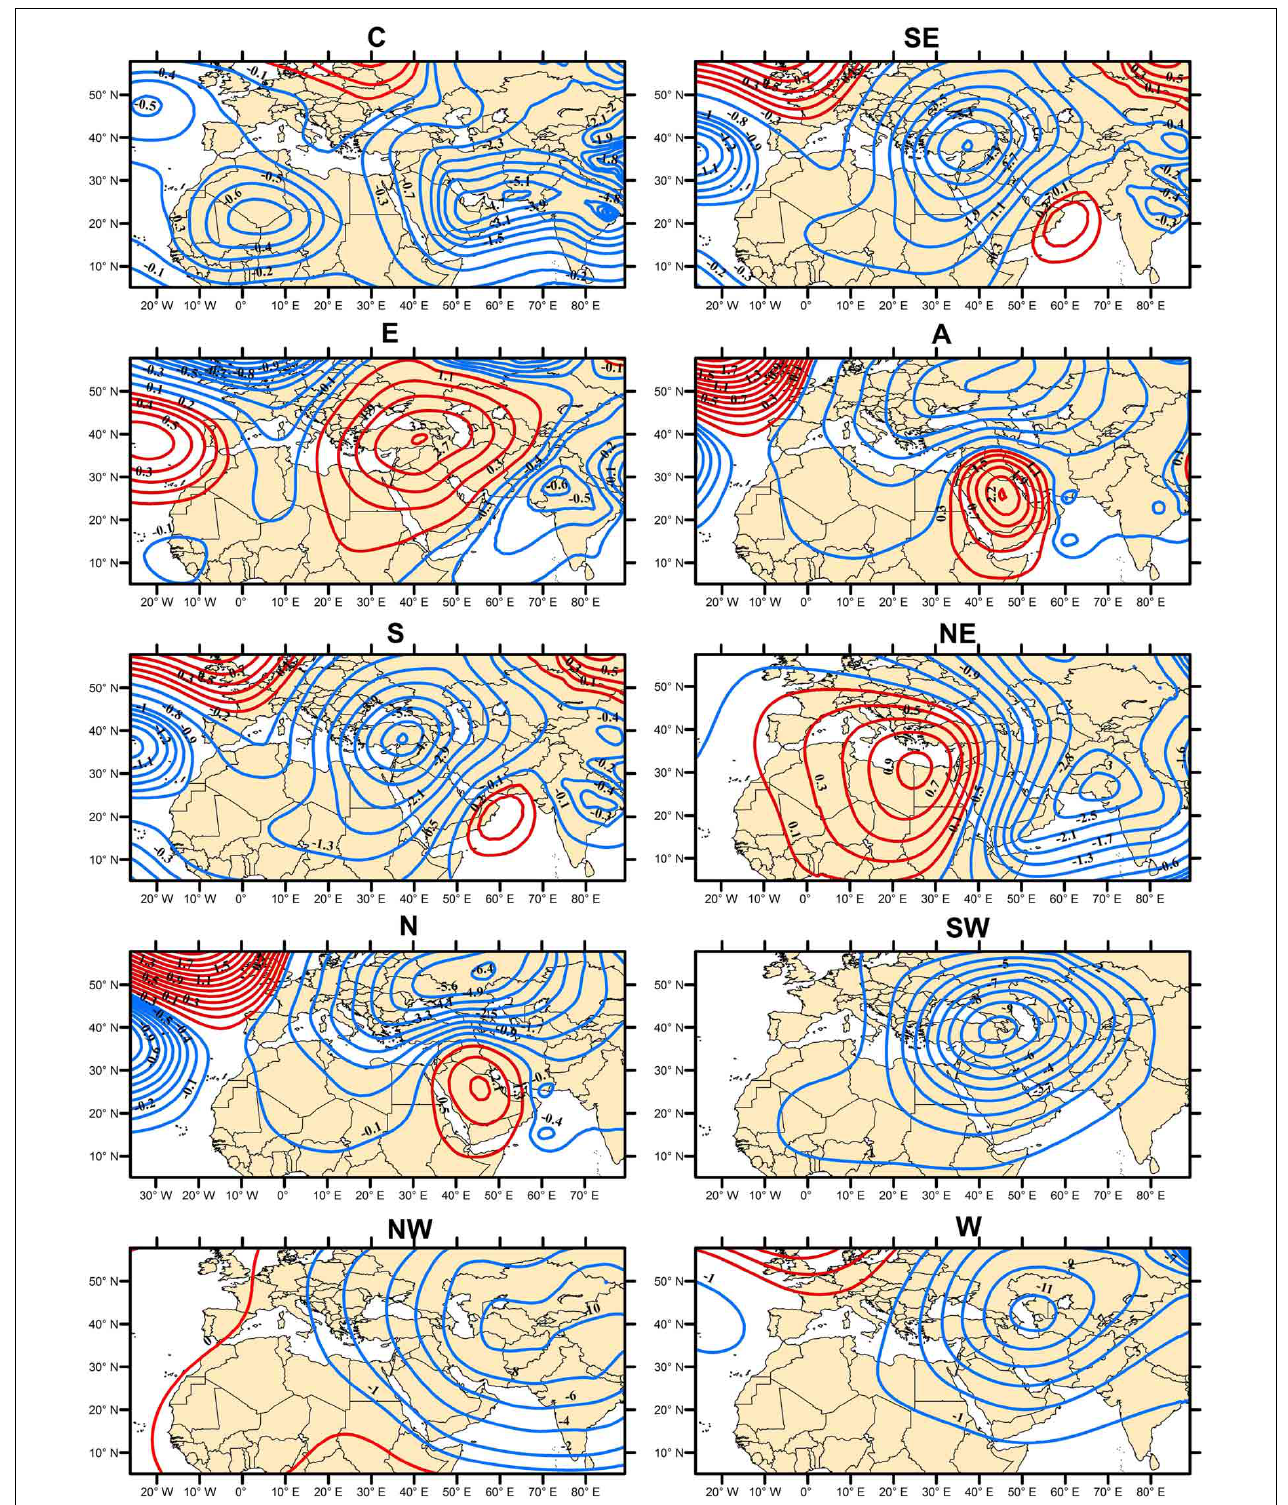
FIGURE 6 | CompositemapsofanomalySLPfieldsforthe10weathertypescalculatedforthe1960–2005period. Positive(negative)anomaliesareshownin red(blue).Dailyanomalieswerecomputedbysubtractingthedailylong-termmean(1960–2005)ofSLPfromthemeanofalldayscorrespondingtoaparticulartype.